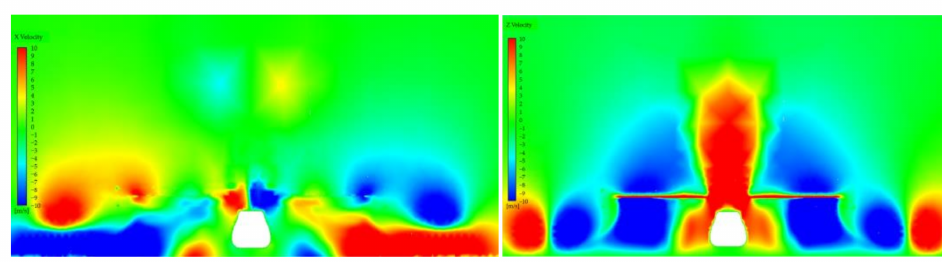
Figure 6. X-direction and Z-direction velocity contours.